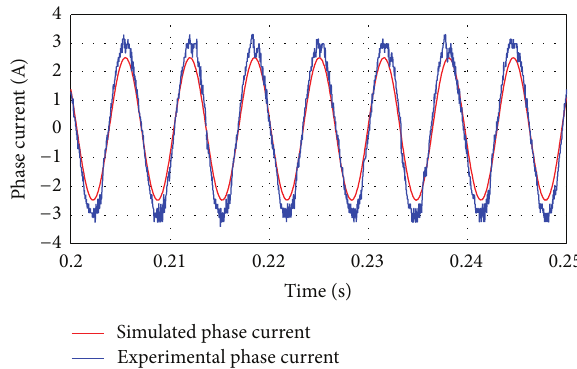
Figure 13: Comparison of phase current between simulation and experimental results.